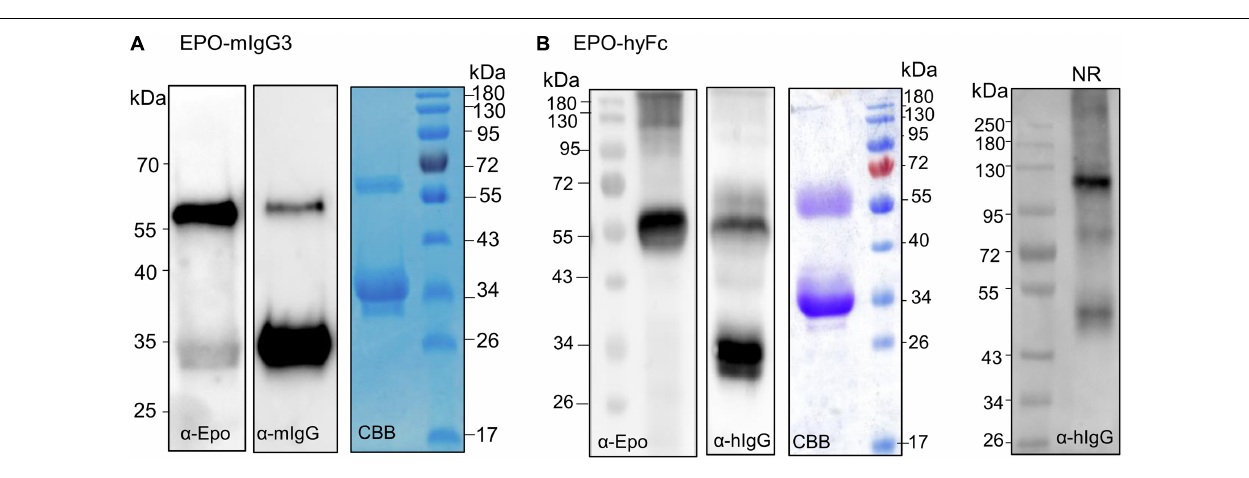
FIGURE 3 | Analysis of the expression of EPO-IgG3 and EPO-HyFc. (A) Total soluble protein (TSP) extracts from N. benthamiana (cid:49) XTFT leaves expressing EPO-mIgG3 were analyzed by immunoblotting with anti-EPO and anti-mouse IgG antibodies. EPO-mIgG3 was purified out of TSP with protein G and stained with Coomassie Brilliant Blue under reducing conditions (CBB). (B) TSP from N. benthamiana (cid:49) XTFT leaves expressing EPO-hyFc were analyzed by immunoblotting with anti-EPO and anti-IgG. Protein A purified proteins were stained with Coomassie Brilliant Blue under reducing conditions (CBB). Oligomerization of EPO-hyFc was evaluated in 8% native PAGE of TSP non-reducing samples. Protein size markers are shown in kilo Dalton